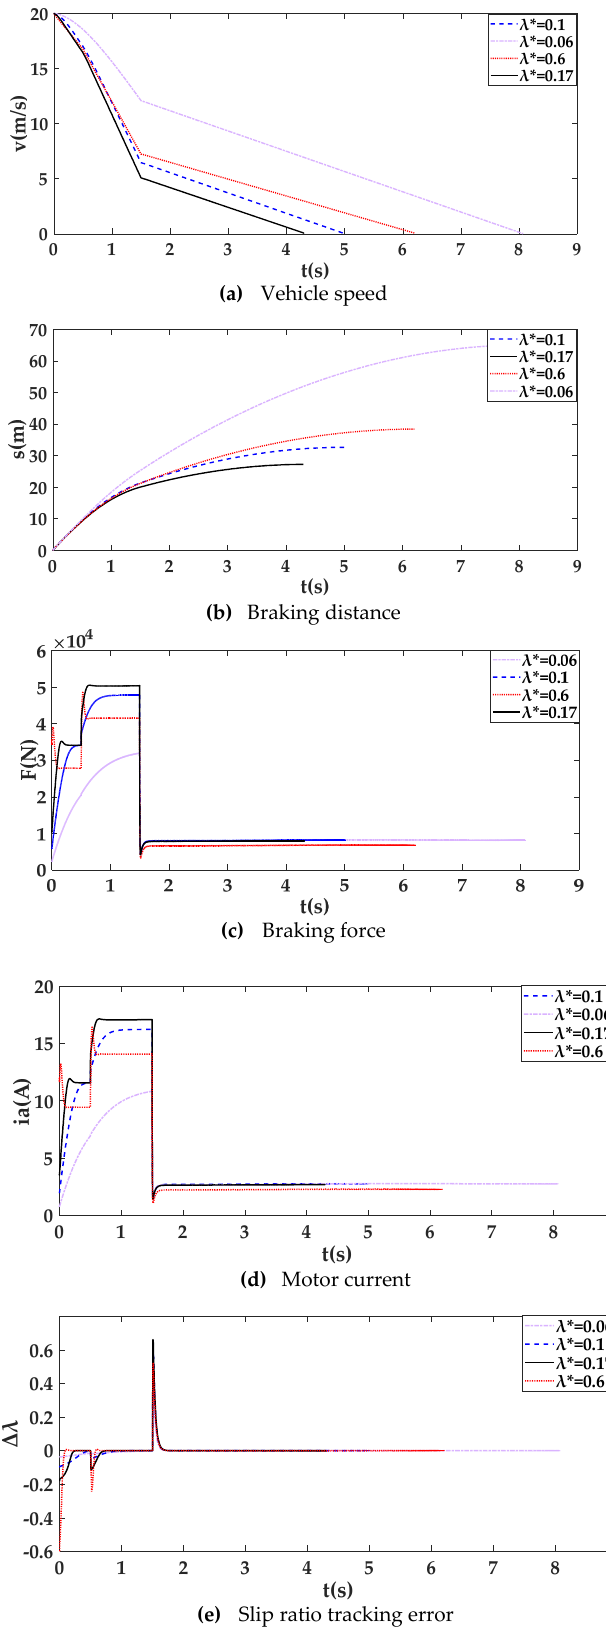
Figure 11. Variable ‐ type road surface simulation. Figure 11. Variable-type road surface